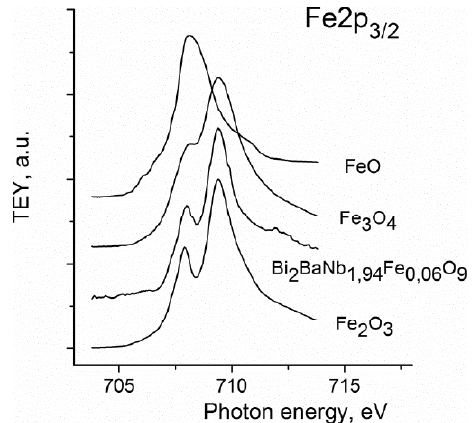
Fig. 6 NEXAFS Fe2p ing solid solutions Bi ides FeO, Fe